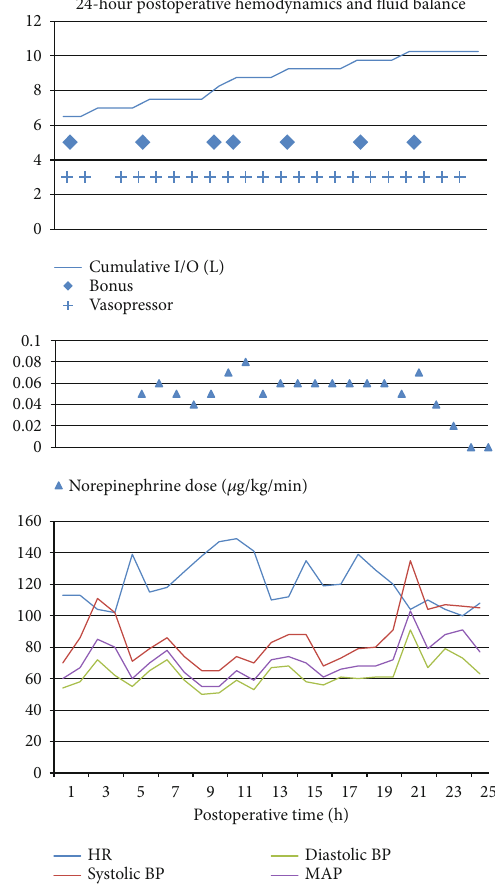
Figure 2: Postoperative hemodynamics and fl uid balance data include measurements of blood pressure (BP) in millimeters of mercury (mmHg) and include systolic BP, diastolic BP, and mean arterial pressure (MAP). Heart rate (HR) is presented in beats per minute. Cumulative input and output (I/O) is for the patient ’ s entire hospital course and is presented in liters (L). Starting at one hour postoperative, the patient was approximately 6 liters positive. Crystalloid and colloid boluses are designated under the